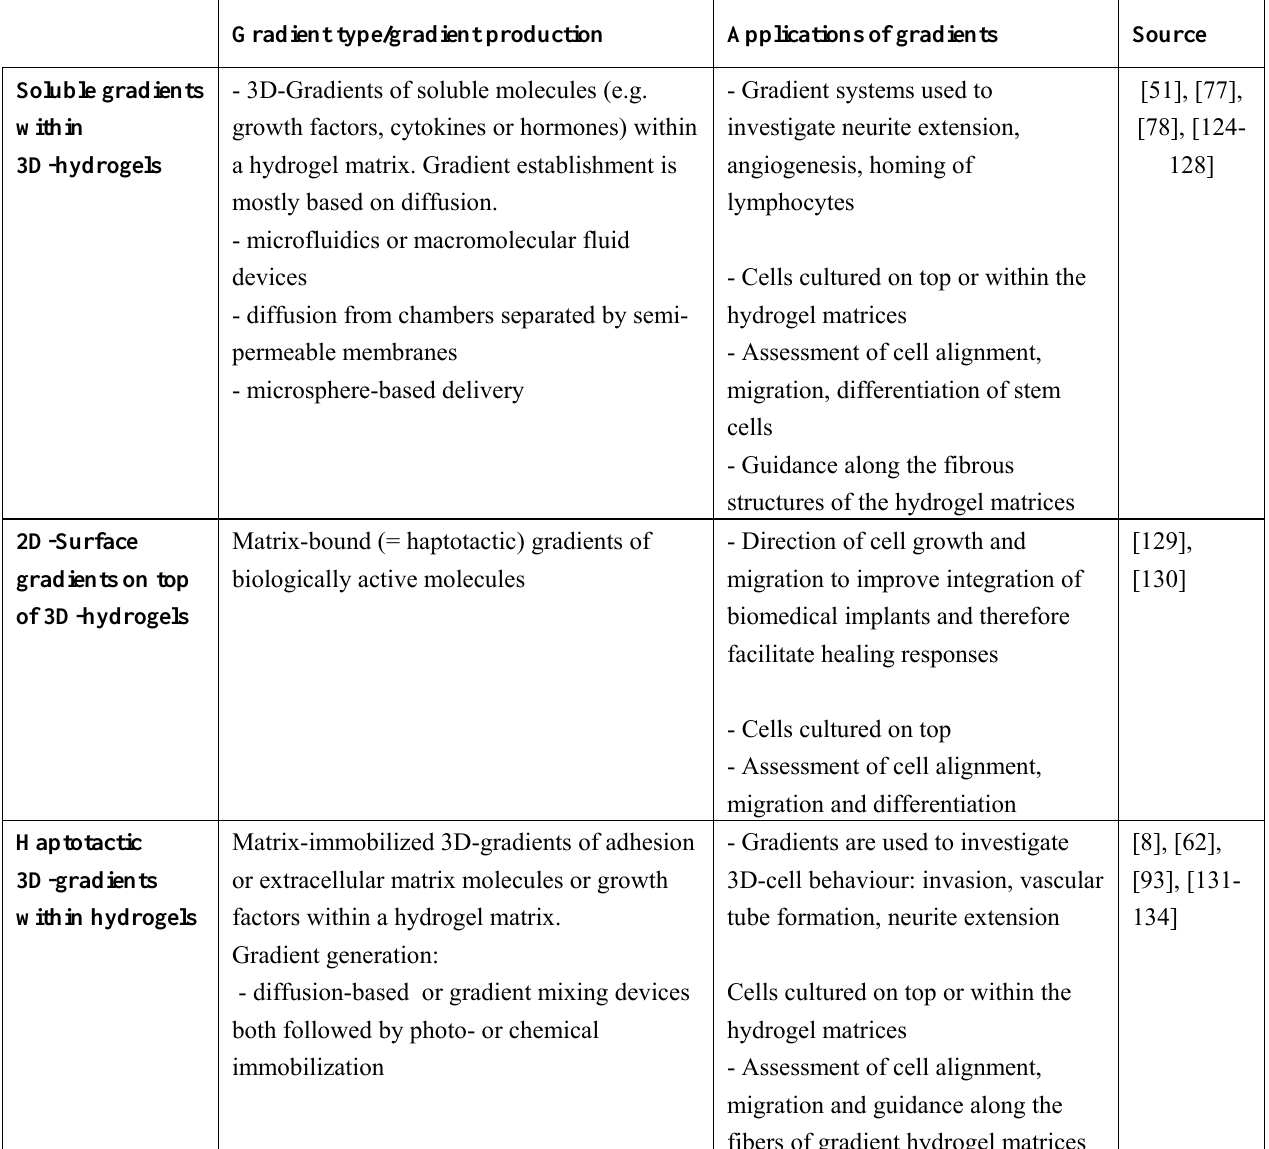
Table 1. Gradients in 3D-hydrogel